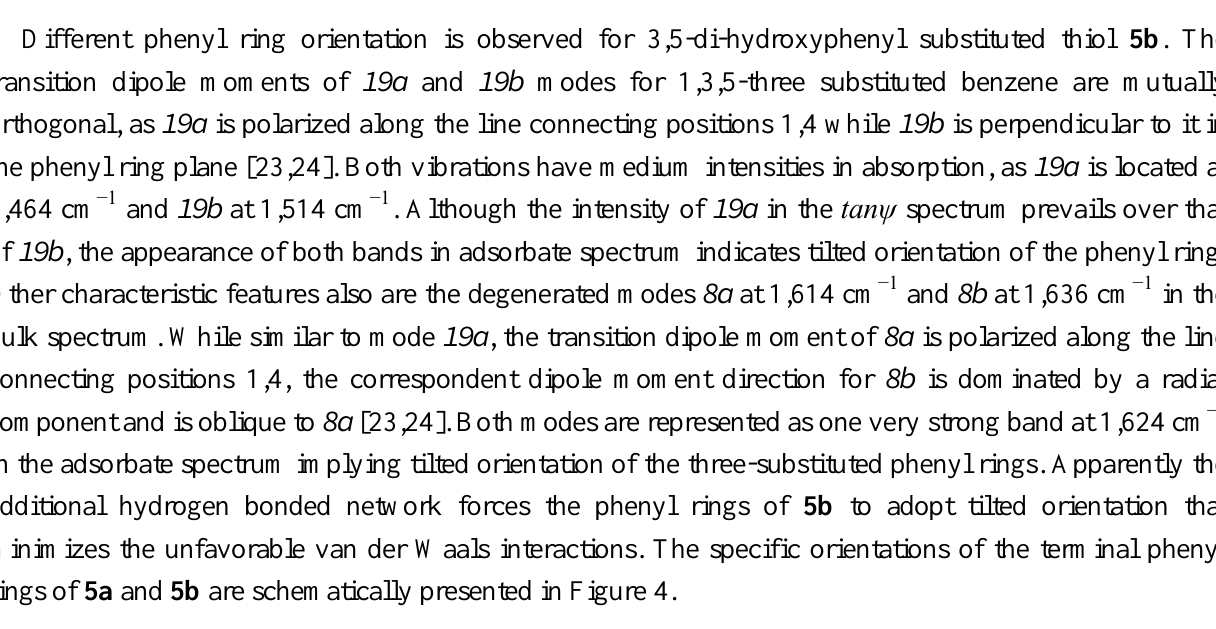
Figure 4. Schematic drawings of the orientation of molecules 5a (left) and 5b (right) on